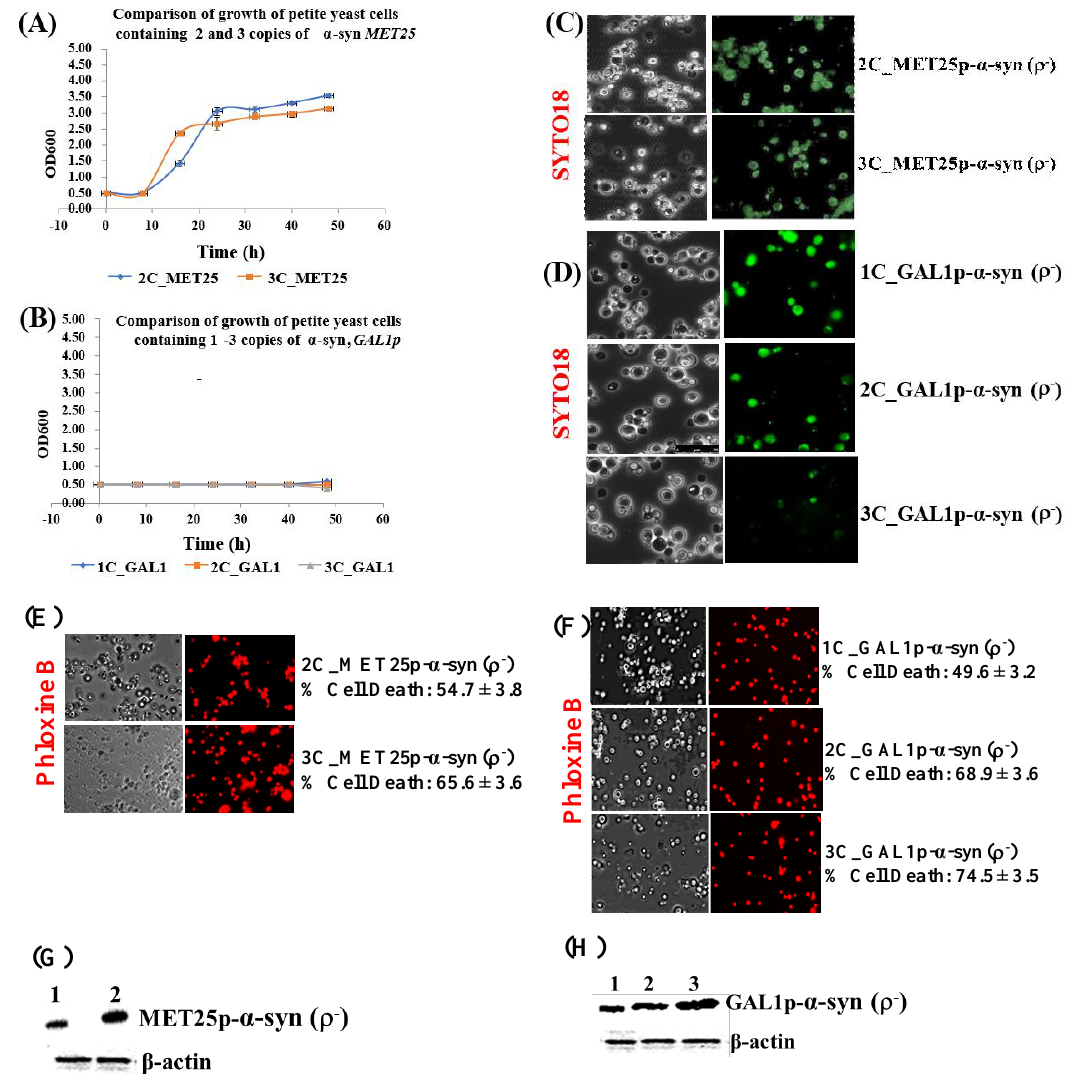
Figure 2. ( A , B ) Comparison of the growth curves of ρ - cells expressing 2–3 copies of α-syn from MET25 p (A) and 1–3 copies of α-syn from GAL1 p (B); cells were grown in YPD ( A ) and YP-galactose ( B ). Bonferroni post hoc test after a significant two-way ANOVA indicates no significant difference in growth between yeast petites that contain different copies of the α-syn gene. ( C , D ) Microscopic images (×400) of petite cells, where expression of 2–3 copies ( MET25 p) or 1–3 copies ( GAL1 p) of α-syn gene was induced, stained with the dye SYTO18. ( E , F ) Microscopic images (×400) of petite cells expressing 2–3 copies of α-syn from the MET25 p (E) and 1–3 copies of α-syn from the GAL1 p, staining with Phloxine B. ( G , H ) Western blot analyses of cells expressing 1 to 3-copies of α-syn protein after full induction of the MET25 p (G) or GAL1 p ( H ). On lanes, 1, 2 ( G ) and 1, 2 and 3 ( H ) were loaded 7.5 µg of total protein obtained after lysis of cells that express 2-copies or 1-copy (lanes 1; G , H ), 3-copies or 2-copies (lanes 2; G , H ) and 3-copies (lane 3; H ) of α-syn, after the growth of cells under conditions that fully induce the MET25 or GAL1 promoter. The upper panel was probed with an antibody that recognizes human α-syn (Proteintech, #10842-1-AP) and the lower panel with a β-actin antibody (Proteintech, 60008-1-Ig); Densitometric quantification of the α-syn bands in ( G , H ) is shown in Supplementary Materials, Parts 3 and 4. Post Hoc Newman-Keuls test, after a significant one-way ANOVA test, indicated a significant difference in cell death, p < 0.01, between petites expressing α- syn with different copy numbers.